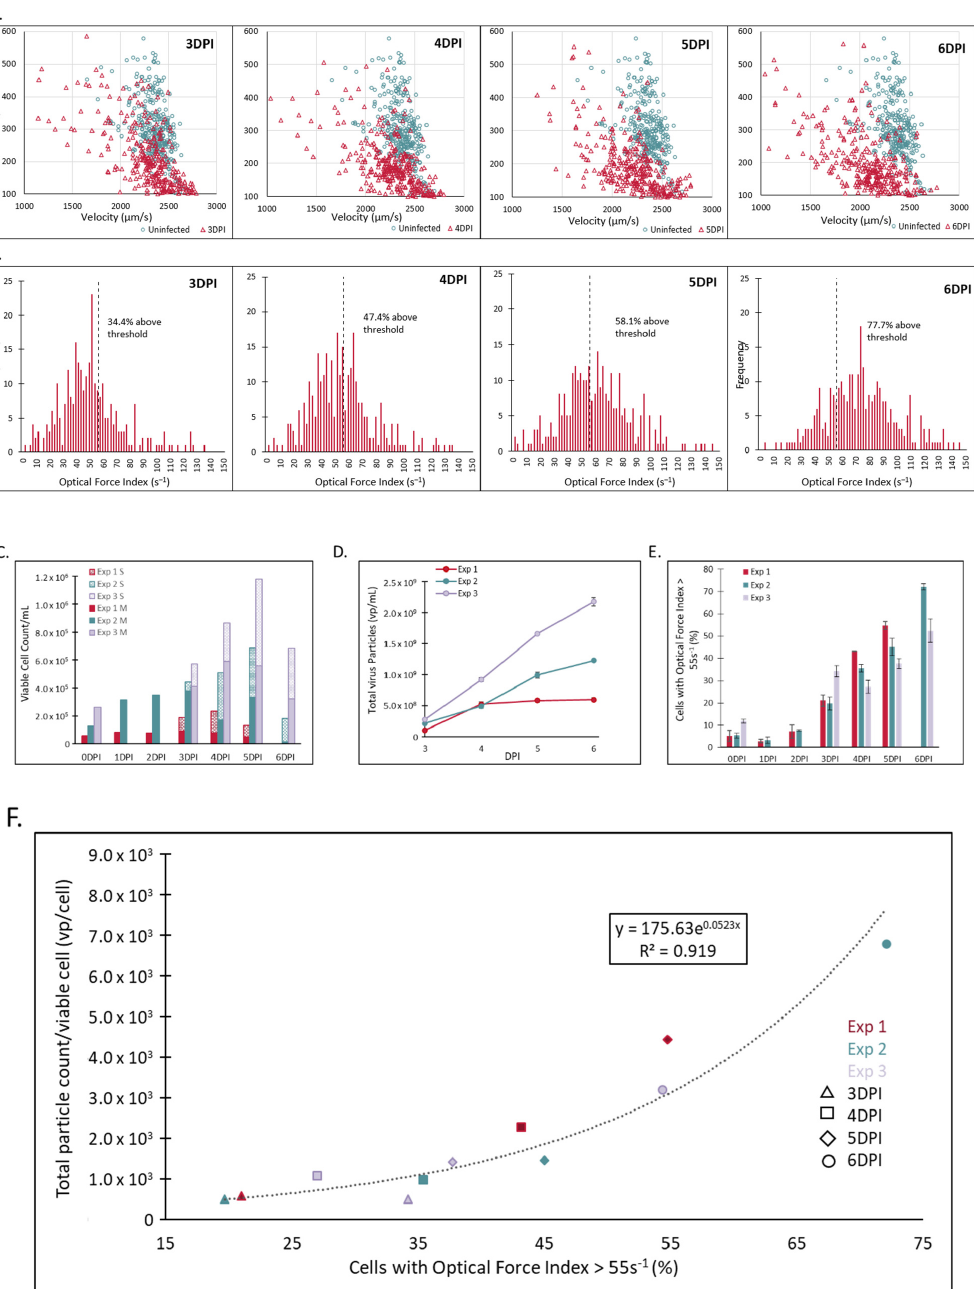
Figure 3. LumaCyte Radiance analysis of Vero cells grown on microcarriers and infected with AV1 at the 3 L bioreactor scale resulted in an infection metric that correlates with total particle counts. ( A ). Representative scatter plots compare cell area-based size vs. velocity profiles for uninfected cells (blue) and AV1 infected cells (red) at 3 through 6 days post-infection (3 − 6DPI). Each dot rep- resents a single cell analyzed by Radiance. ( B ). Representative histograms show the differences in optical force index profiles for AV1 infected cells for days 3 through 6 post-infection (3 − 6DPI). Bar heights represent the number of cells with an optical force index falling within the given bin range (bin width = 2). The dotted line represents the optical force index threshold set as the Radiance in- fection metric (OFI > 55 s − 1 ) for this study. The percentage of the cell population with an OFI > 55 s − 1 is shown on each plot. ( C ). Viable cell concentration for the supernatant (S) and microcarrier (M) cell fractions of AV1-infected cells measured using Vi-CELL BLU at each time point. ( D ). CytoFLEX total virus particle concentration of MV samples from three 3 L experiments across varying days post infection ( n = 3). ( E ). Progression in Radiance infection metric (percentage of cells with OFI > 55 s − 1 ) for cells infected with AV1 from 0 days post-infection (uninfected) through 6 days post-infec- tion across three 3 L bioreactor experiments. This value accounts for the percentage of cells in both the S and M fractions ( n = 3). ( F ). Correlation between Radiance infection metric (percentage of cells with OFI > 55 s − 1 ) and CytoFLEX total particle counts normalized to the viable cell count for AV1 infected cells across three independent bioreactor experiments. Each point represents the timepoint and experiment indicated on the plot (R 2 = 0.92, n = 3). Table 2. Calculated Potency Values for AV1-infected bioreactor samples. Table detailing days post- infection (DPI), Radiance infection metric, total virus particle counts used as surrogate potency, and calculated potency in terms of vp/viable cell based on the correlation between the LFC data and flow cytometry data for all three AV1 3 L bioreactor experiments. The average log 10 difference be- tween the measured and calculated potencies for each sample timepoint as well as the absolute av- erage for all samples across all three experiments are given in the final column. Experiment